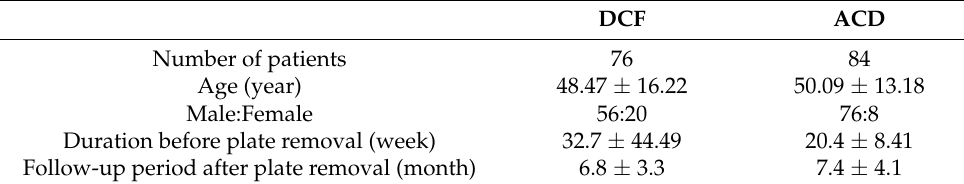
Table 1. Demographics of patients receiving hook plates.